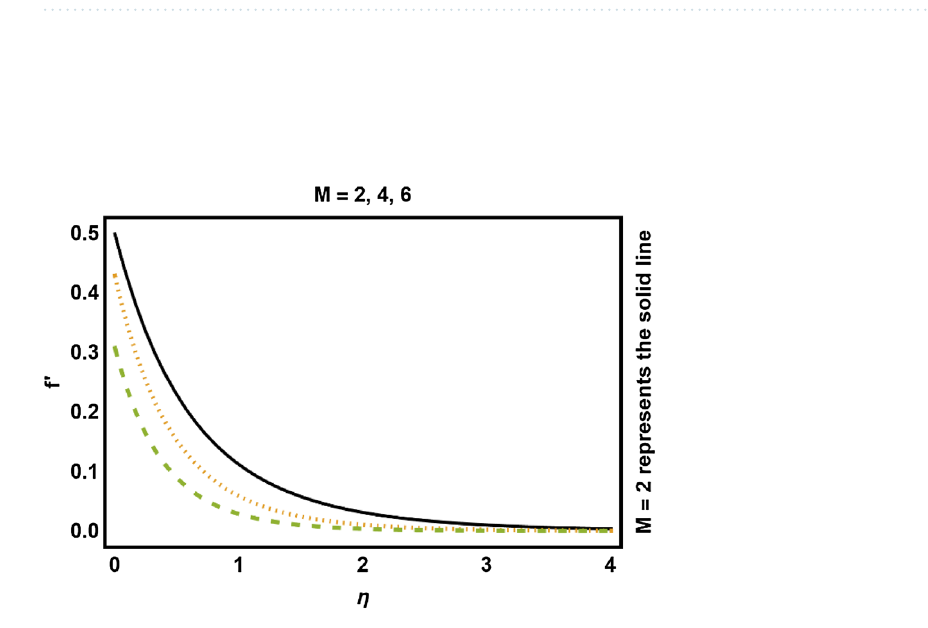
Figure 3. Magnetic effects on velocity